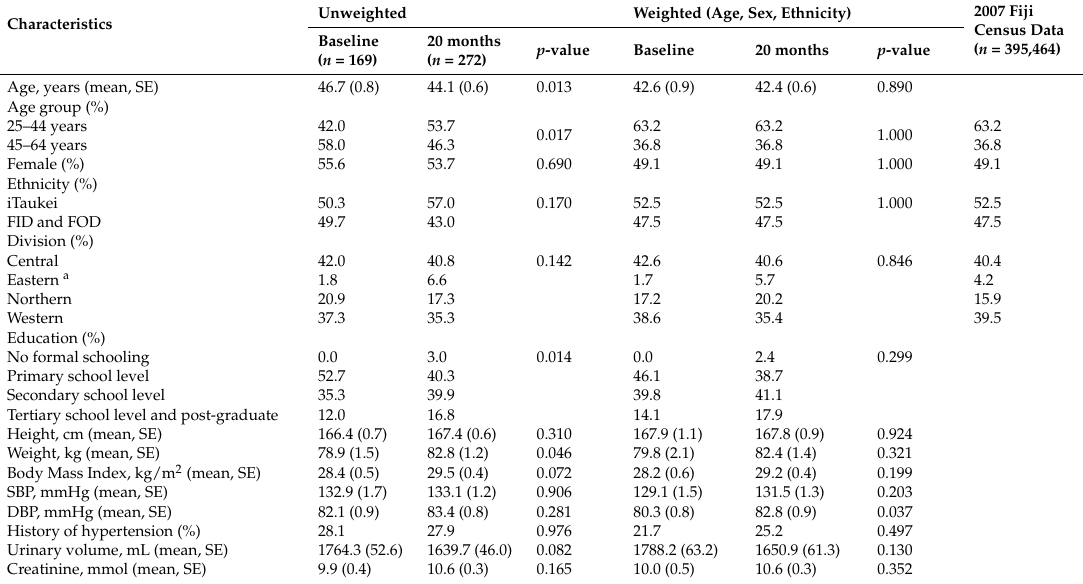
Table 2. Characteristics of participants surveyed at baseline and after 20 months.